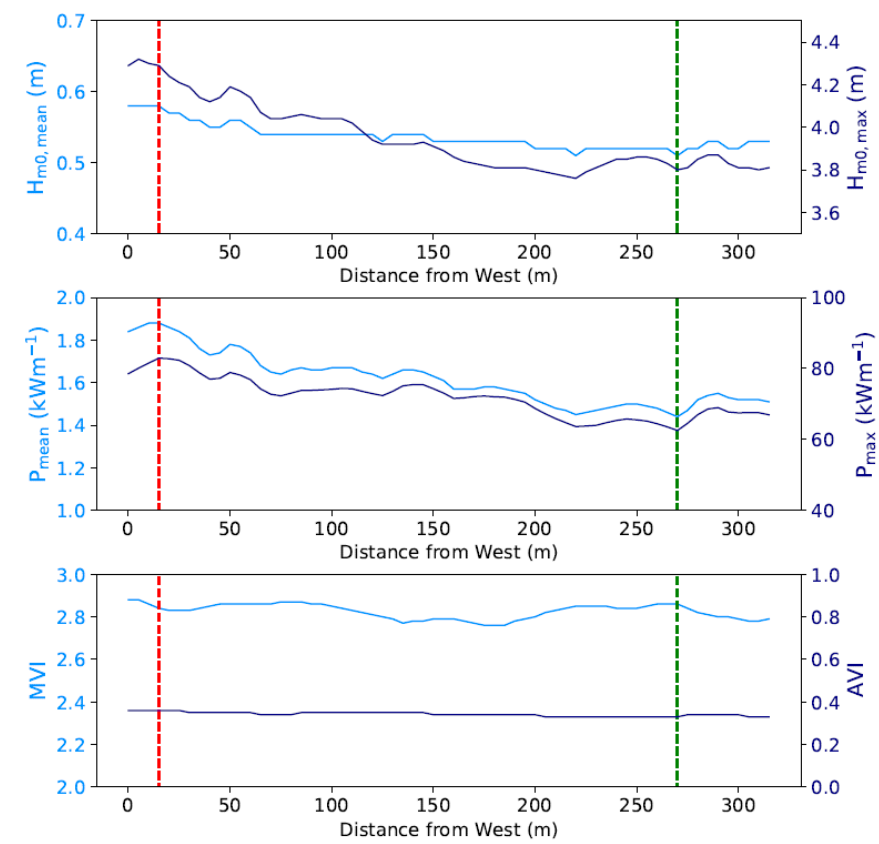
Figure 7. Spatial distribution of ( top ) the averaged and maximum significant wave heights, ( center ) the averaged and maximum available wave energy fluxes and ( bottom ) the monthly and annual variability indexes (MVI and AVI) computed from SWAN predictions along the line considered offshore from the harbour breakwater. The vertical dotted red and green lines show the locations of points considered for the investigation of WEC performance in Section 4.3. Please also note that different vertical axes are used for these parameters.